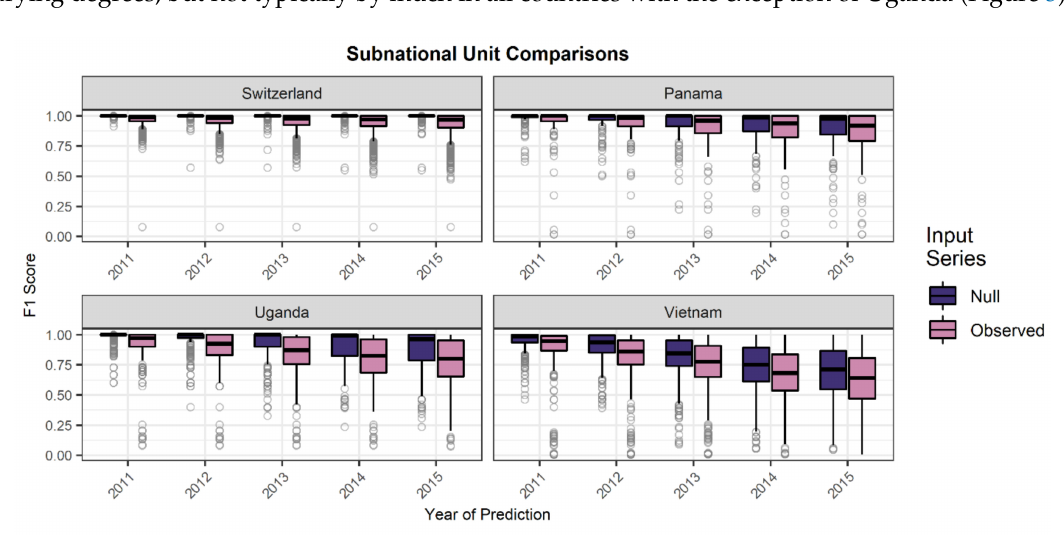
Figure 3. Boxplots of unit-level F1 scores across countries and years in the projection period and divided by the input time series to the BSGMe framework. All F1 scores were calculated by comparing pixel-level agreement / disagreement with withheld annual European Space Agency (ESA) Remote Sensing (RS)-derived extents. The median is indicated by the black line and outliers (outside of 1.5*the interquartile range) are given by grey